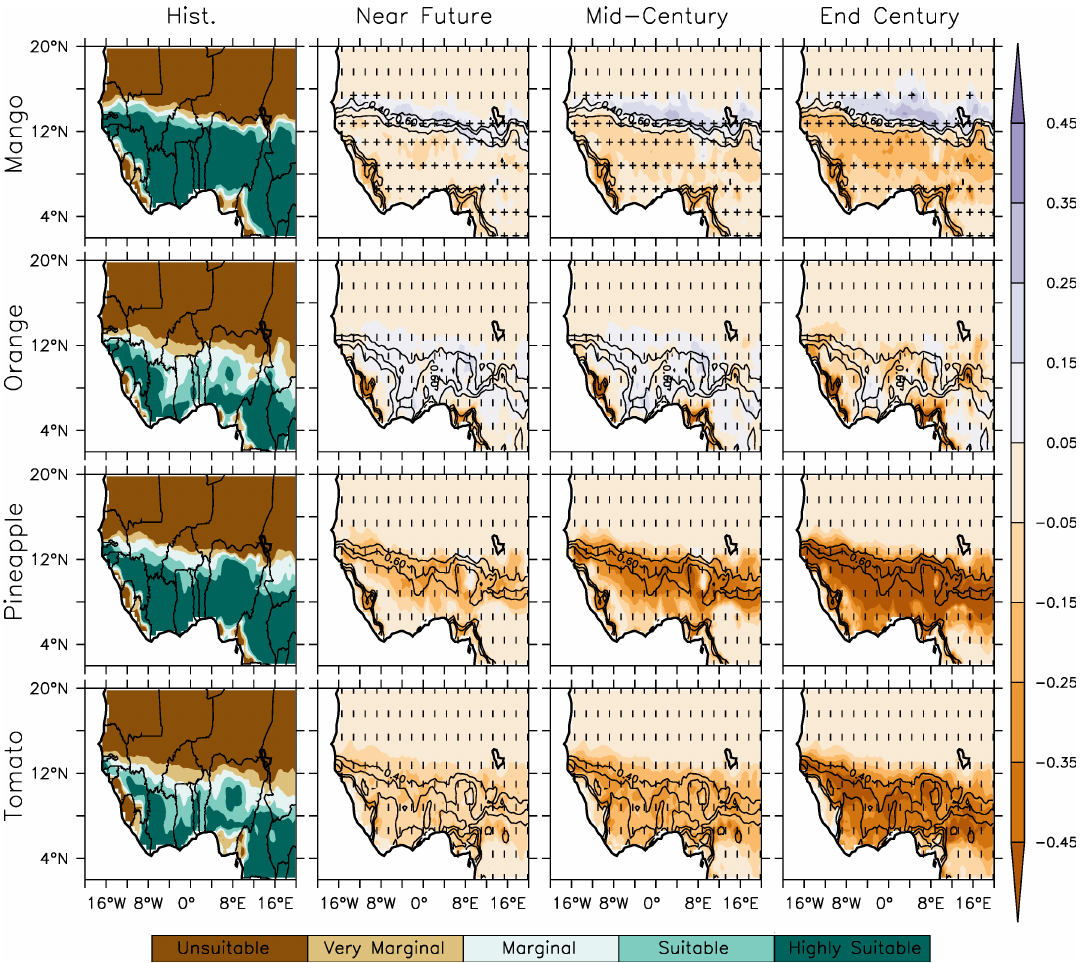
Figure 6. Same as Figure 3 but for the fruit crops, mango and orange and horticultural crops, pineapple and